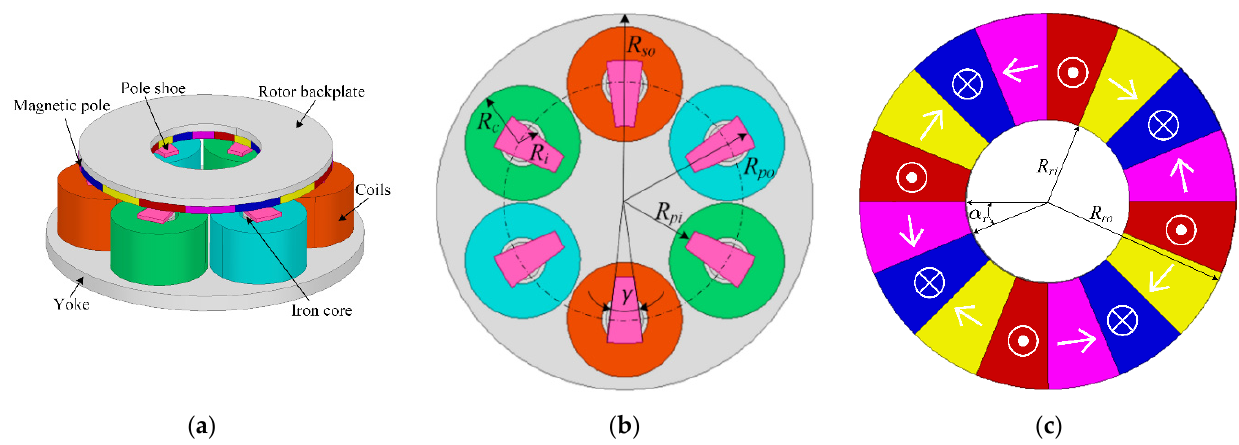
Figure 2. Bearingless motor of the blood pump: ( a ) Single-winding bearingless motor; ( b ) Motor stator; ( c ) Rotor with Halbach array.